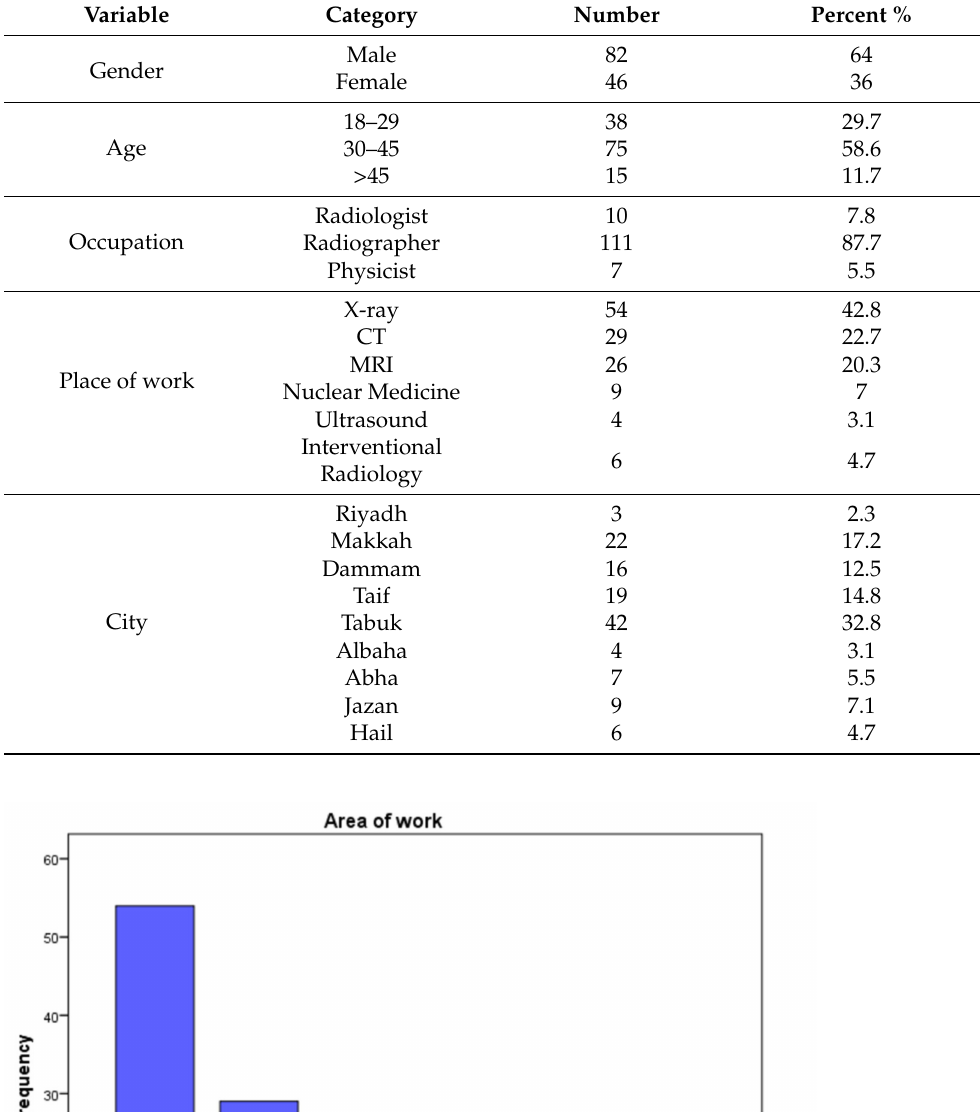
Table 1. Demographic characteristics of participants ( n = 128).